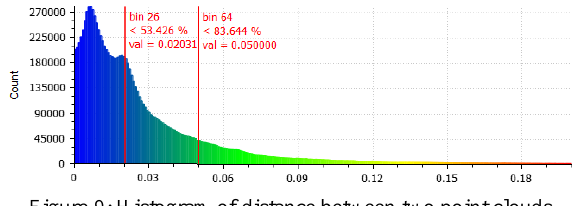
Figure 9: Histogram of distance between two point clouds. The comparison demonstrates that the photogrammetric method using a phone camera generates a comparable point cloud to that from laser scanning, as more than half of the distances (53.4%) were under 2 cm and the majority of the distances (83.6%) were smaller than 5 cm (Figure 9). Here, image distortion was not rectified, and the laser scanned point cloud was simply treated as ground truth, meaning the errors in laser scan registration were not taken into consideration. This accuracy should suffice for the majority of modelling purposes, e.g.